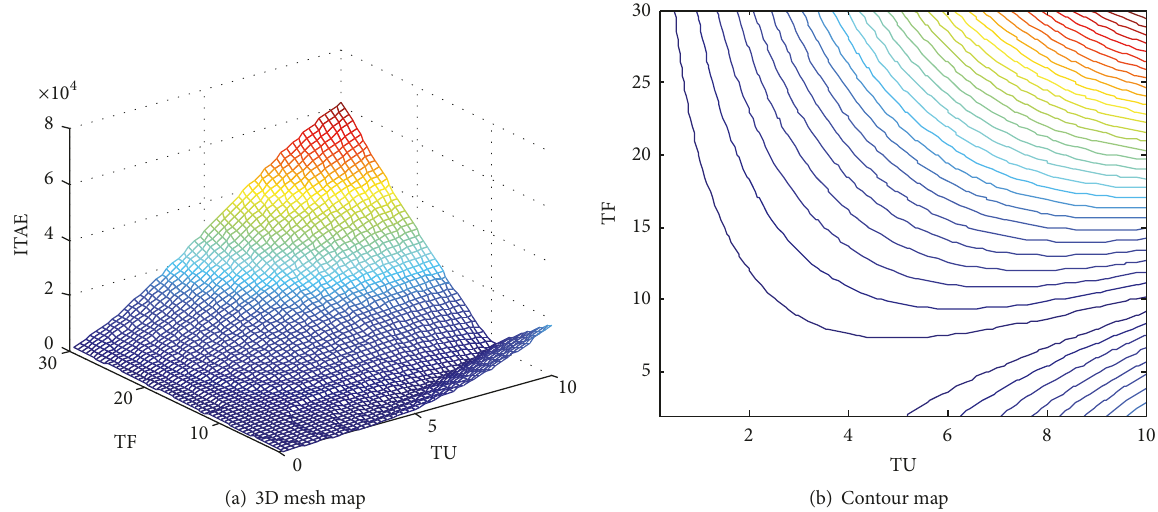
Figure 5: ITAE of linear handling chain system.